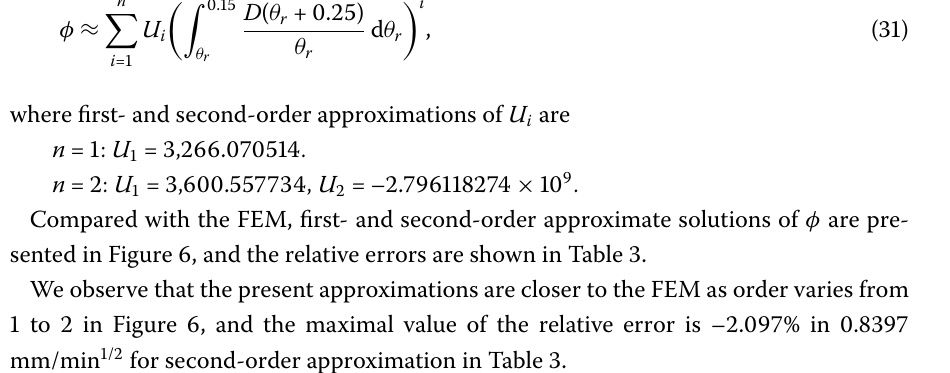
Figure 6 Results of φ obtained from the FEM and approximations of orders 1-2.